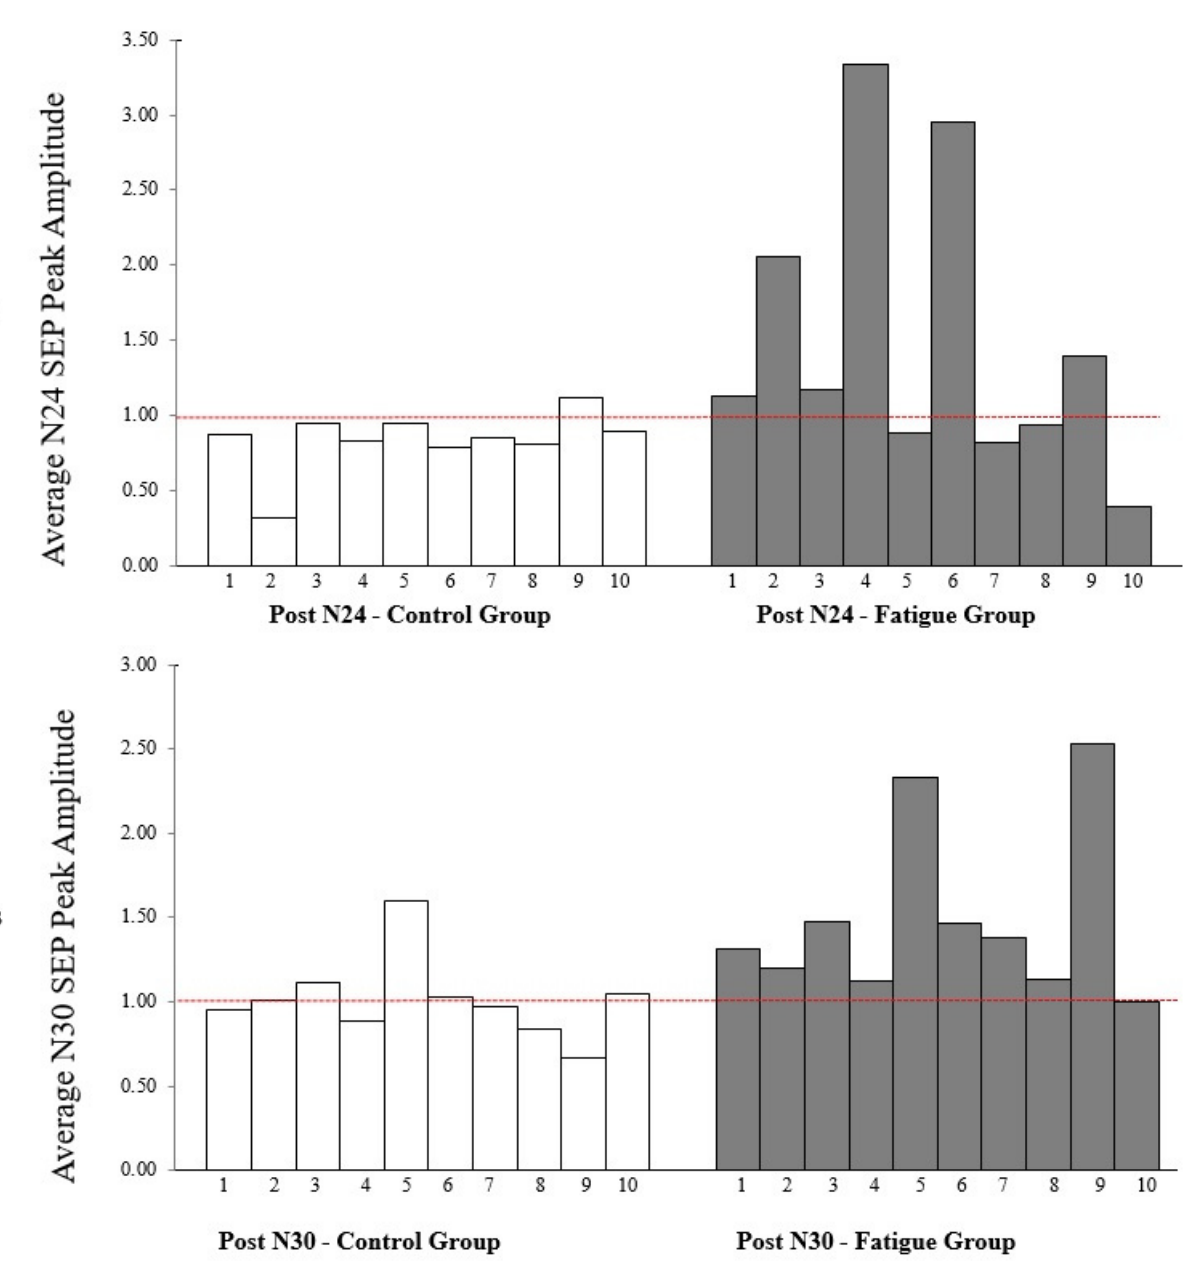
Figure 8. Graphical Representation of each individual performance, ( A ) N24 SEP peak, and ( B ) N30 SEP peak time traces (difference per participants between pre- and post-acquisition). The N24 did not increase in any of the control participants, but it did in the majority of the CEM neck fatigue participants. With the N30, only one control participant showed an increased SEP amplitude, whereas nine of the ten CEM neck fatigue participants showed an increase, while the other participant showed no change.